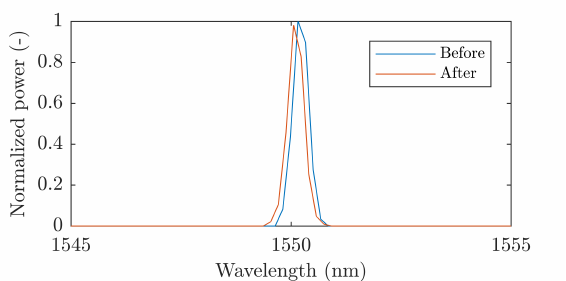
Figure 4. A reflection spectrum of the Bragg grating before and after